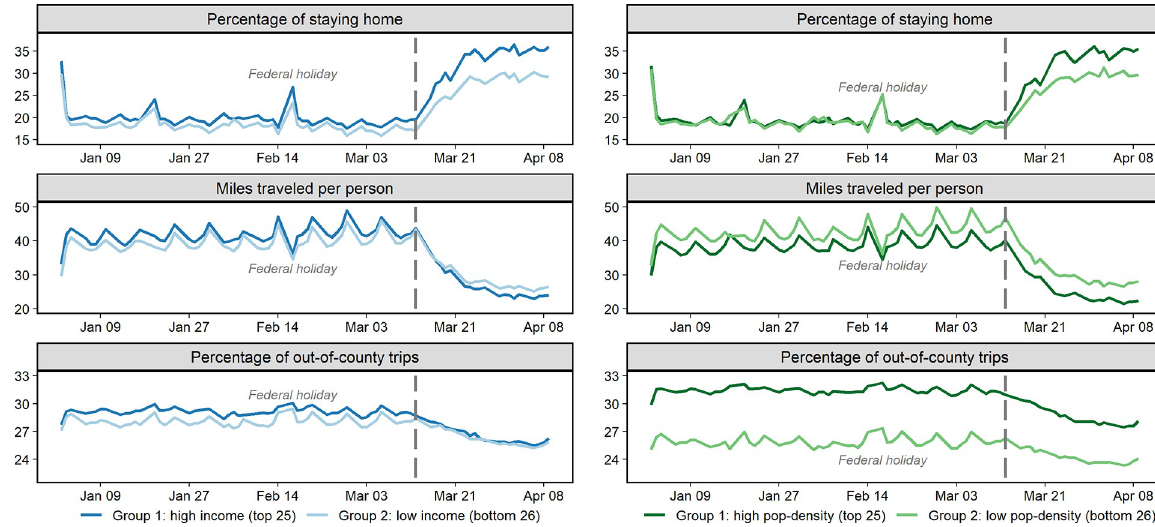
Fig 8. Groupwise mobility pattern comparison. (a) Median income groups (left); (b) Population density groups (right).